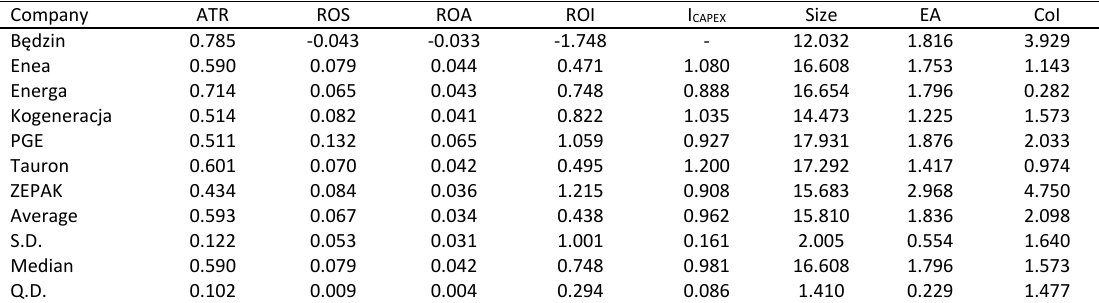
Table 2: Financial and environmental ratios for Polish energy groups in 2013